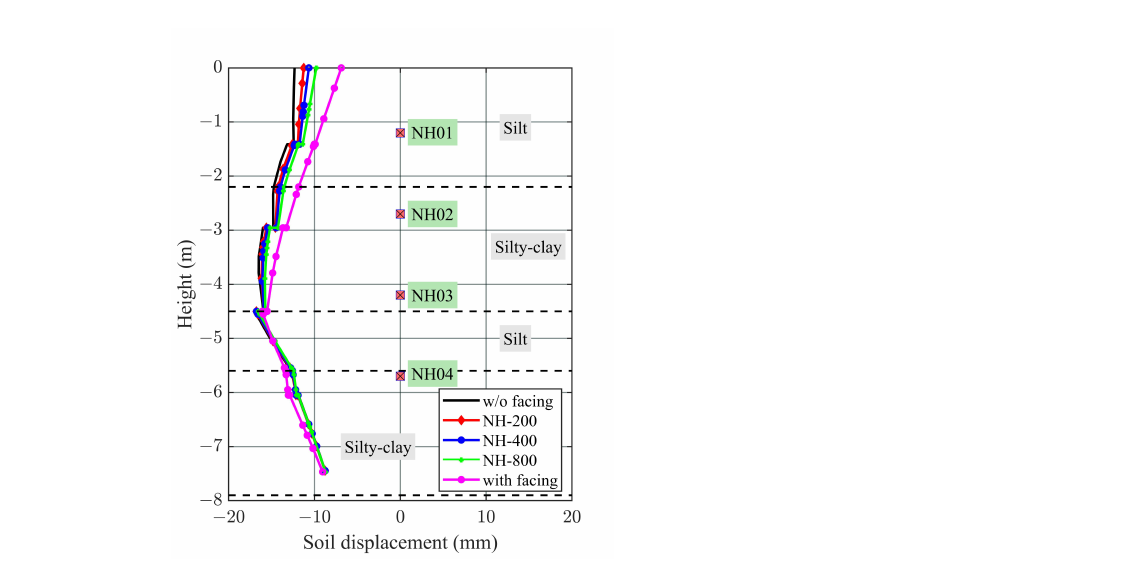
Figure 10. Retained soil displacement profiles generated under nail heads of various sizes and with and without the use of a facing element.